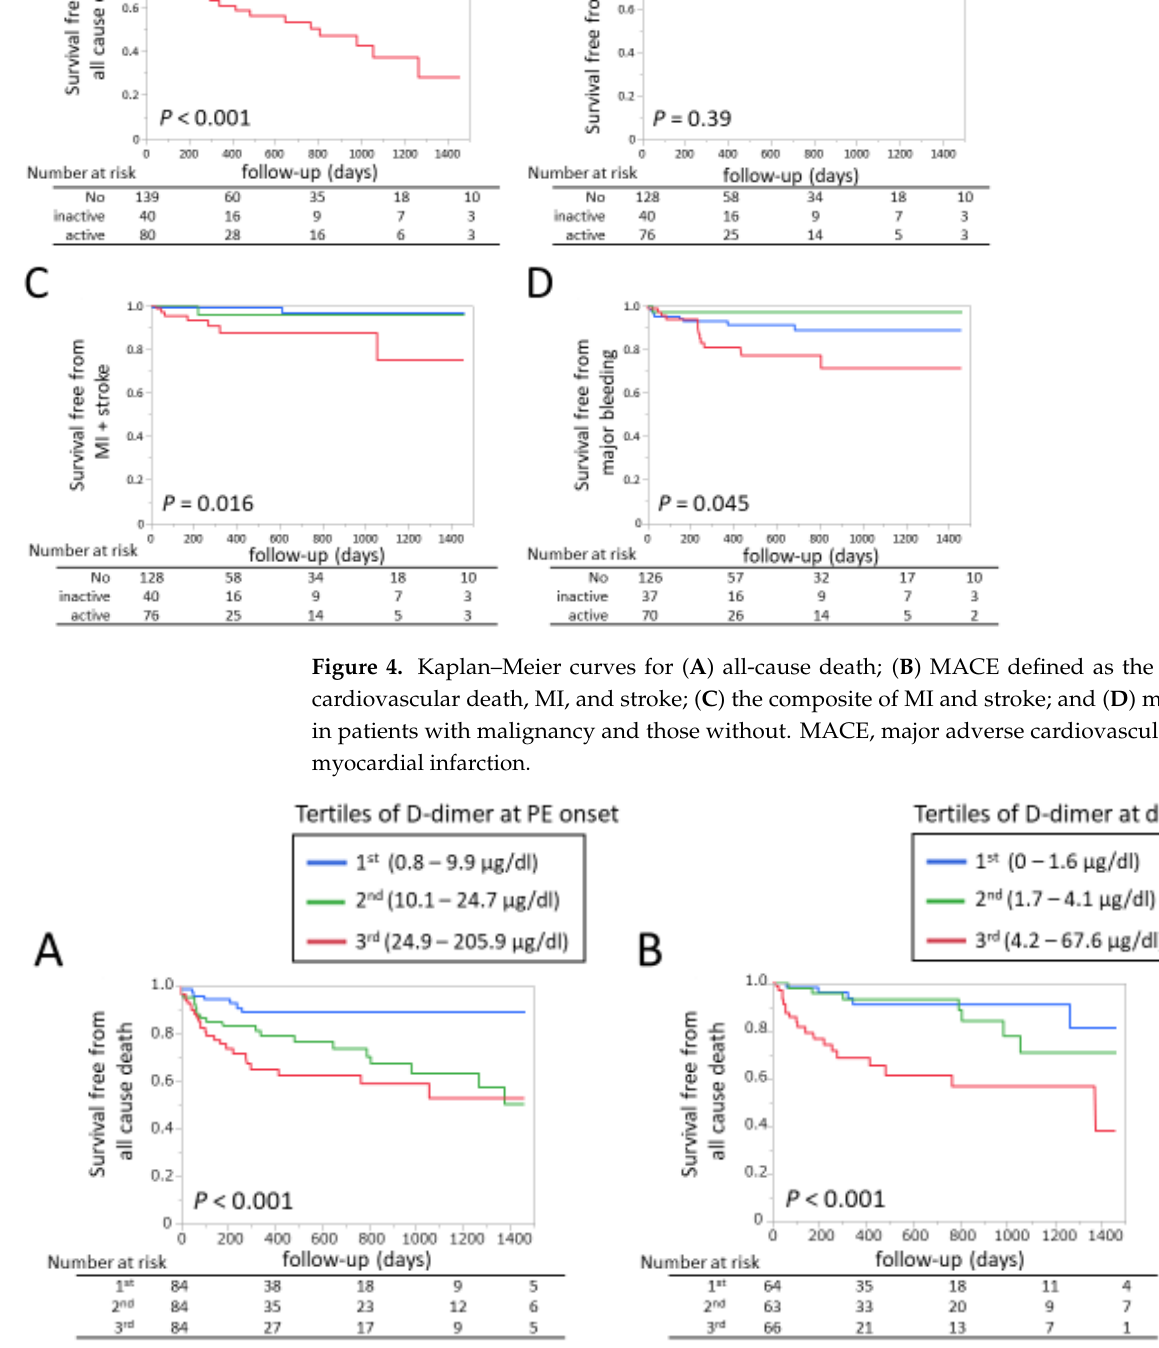
Figure 5. Kaplan–Meier curves for all-cause death in the whole study population divided by ( A ) tertiles of D-dimer at PE onset and ( B ) at discharge. PE, pulmonary embolism.